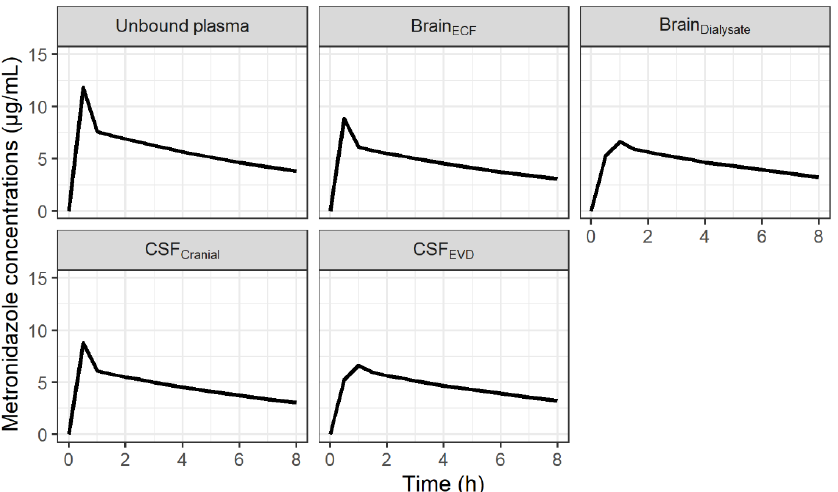
Figure 2. Predicted concentration-time profiles of metronidazole in unbound plasma, brain ECF, brain dialysates after correction by in vivo probe recovery, CSF in the lateral ventricle (CSF LV ) and CSF collected by extra-ventricular drainage (CSF EVD ) for a typical patient after administration of 500 mg q8h.